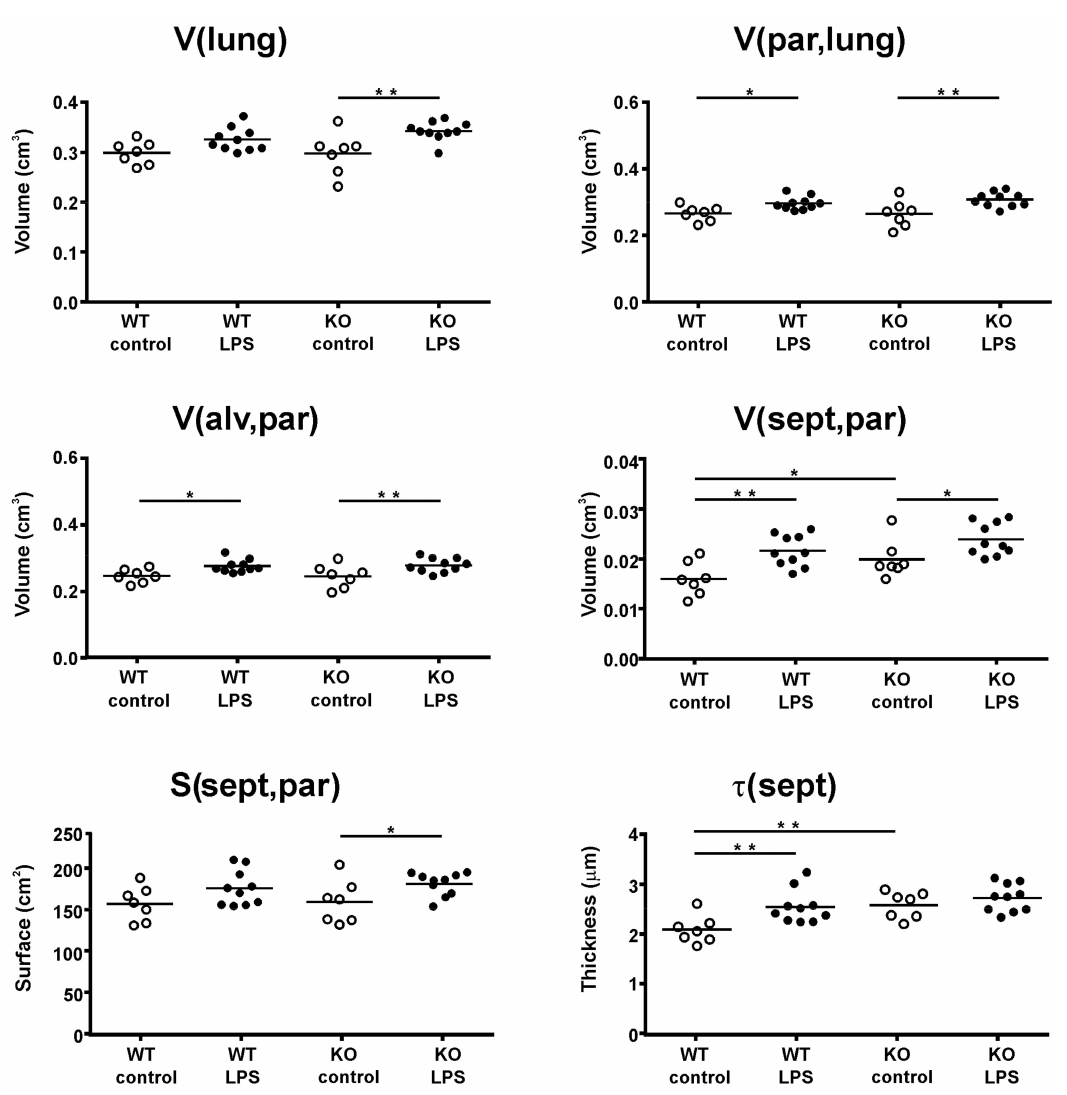
Figure2. Structuralalterationsinlungtissue. Structuralchangeswereassessedintheleftlunglobeusing stereology. The volume of the left lung lobe (V(lung)) was measured with volume displacement. The parenchymal content (V(par,lung)) and its alveolar volume (V(alv,par)) and septal volume (V(sept,par)) were estimated, as well as the septal surface area (S(sept,par)) and septal thickness ( τ (sept)). Each data point represents one animal; means are expressed by horizontal bars; lines indicate statistically significant di ff erences between groups (* p < 0.05, ** p <